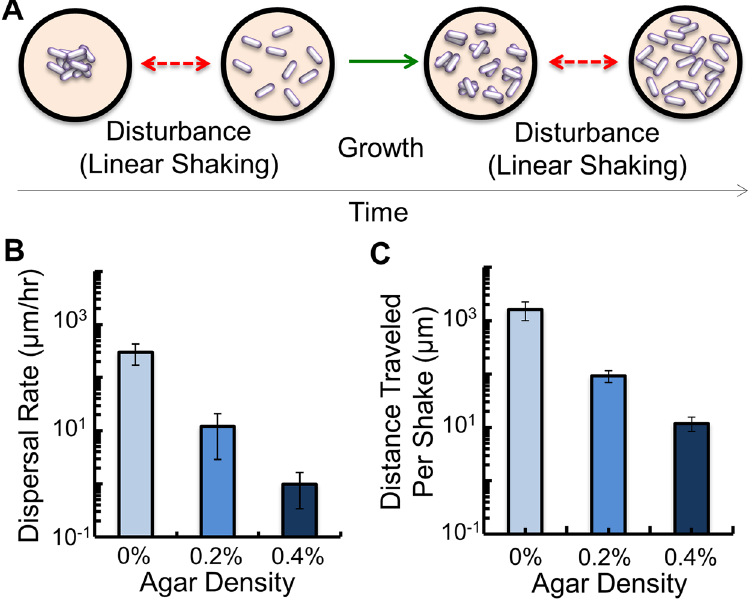
Figure 2. Quantifying the movement of gfp -expressing bacteria during linear shaking. ( A ) We periodically altered the spatial distribution of the bacterial population by shaking the microplate linearly. This dispersed the bacteria away from their positions where, after a period of time, their positions were disturbed again. ( B ) Average dispersal rate of bacteria in medium with different agar densities, and in the absence of shaking (see Methods). p ≤ 0.03 amongst all conditions (two-tailed t-test in panels (A,B)). SD from six biological replicates. ( C ) Average distance travelled by the bacteria after a single shake in the microplate reader (see Methods). For all comparisons, p ≤ 0.05. SD from a minimum of three biological